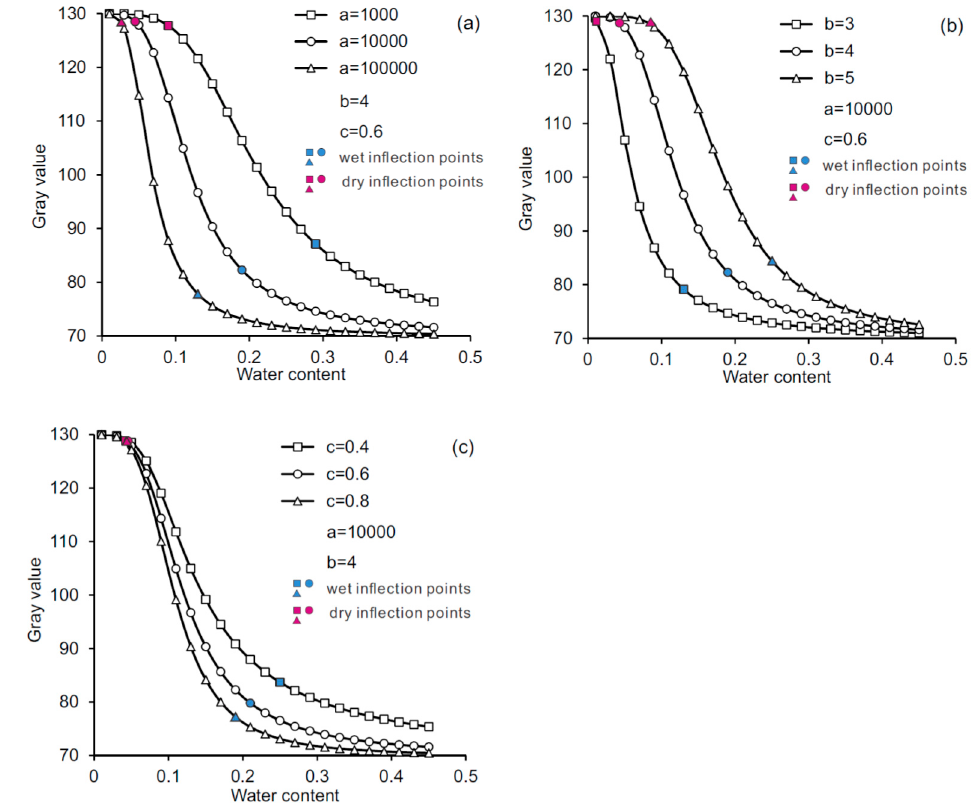
Figure 10. Comparisons of WGCCs using different model parameter values: ( a ) WGCCs with varying parameter a ; ( b ) WGCCs with varying parameter b and ( c ) WGCCs with varying parameter c .